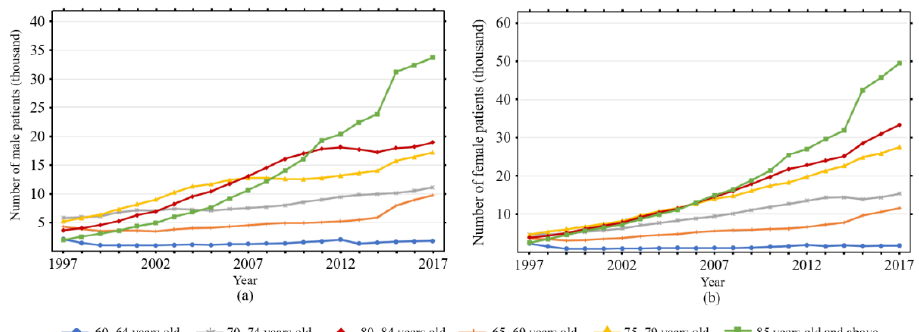
Figure 3. Projected increase in the number of dementia patients in the Taiwan, by age group (1997–2017). ( a ) male; ( b ) female.